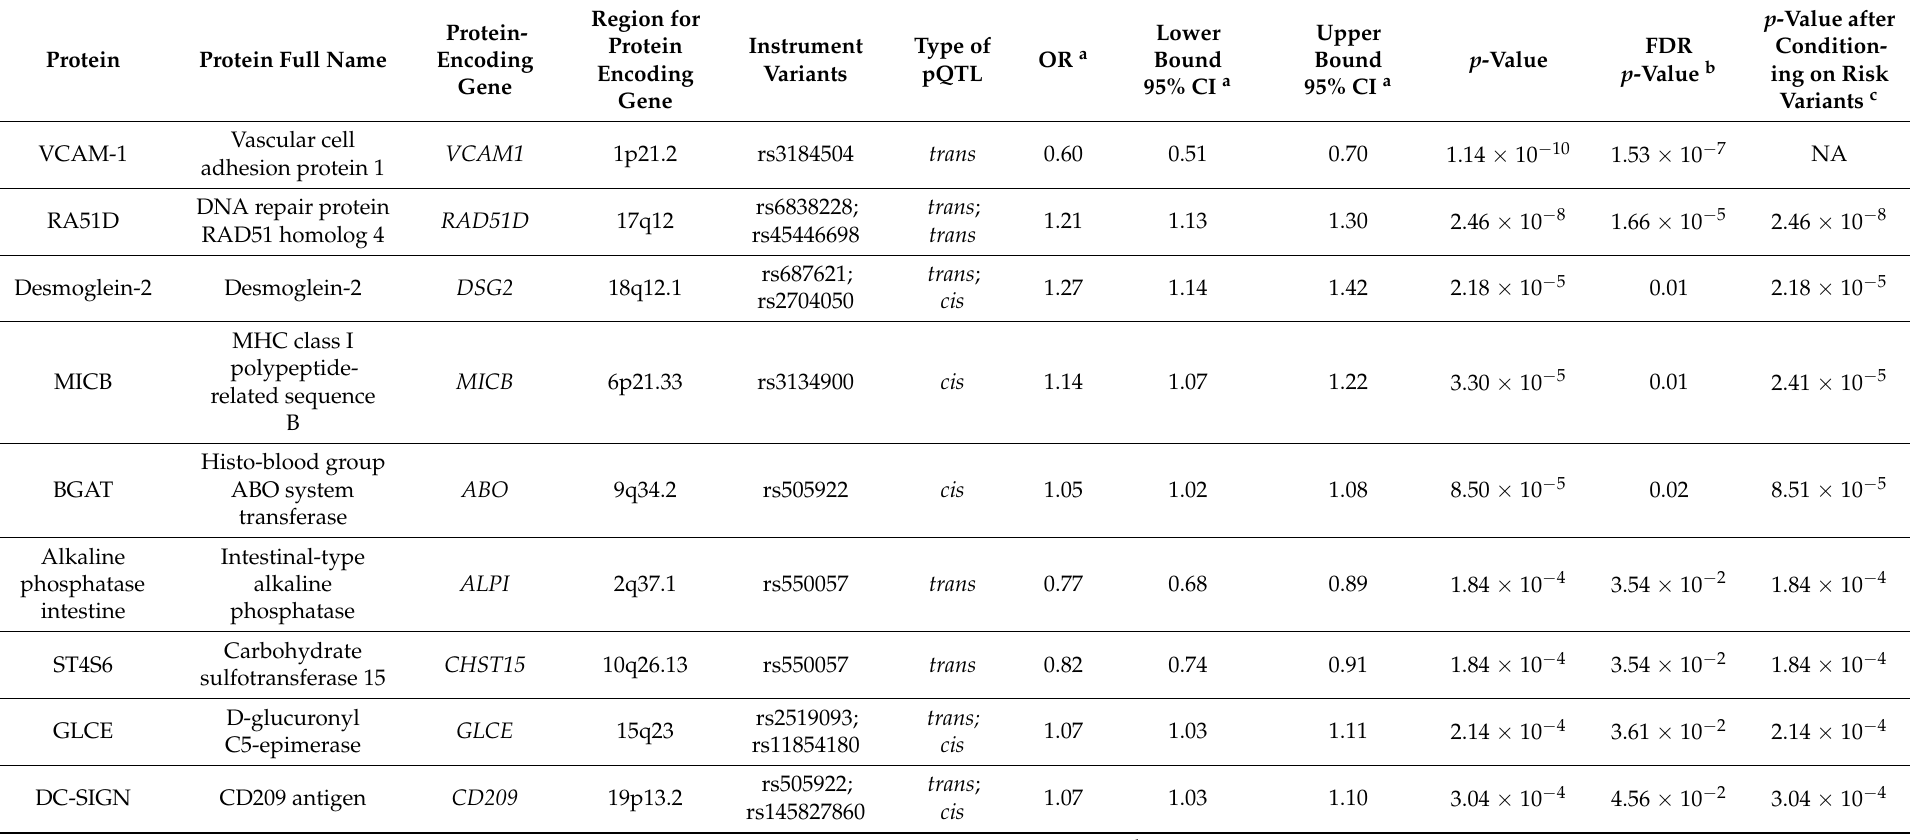
Table 1. Associations between genetically predicted protein concentrations and endometrial cancer